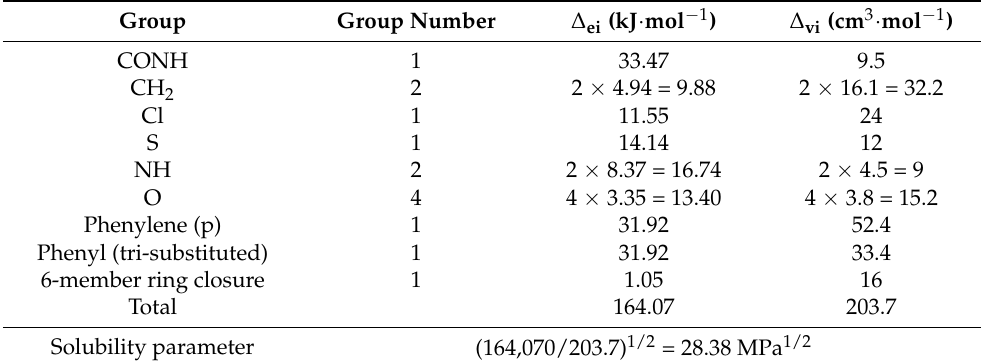
Table 2. Application of Fedors’ method for estimating the internal energy, molar volume, and Hildebrand solubility parameter of GLN.